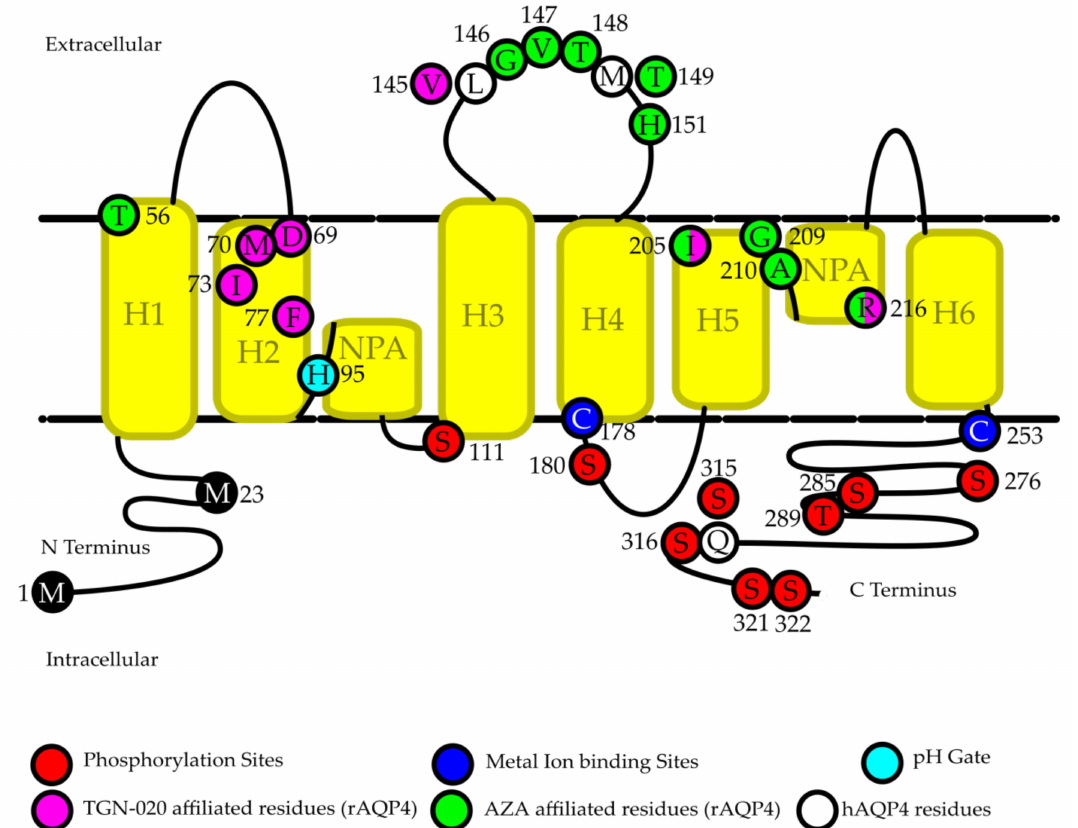
Figure 1. Important residues in AQP4 regulation. The location and function of several important residues identified to have a role in AQP4 regulation. White residues indicate the human equivalent to sites which were identified in rat AQP4 (rAQP4) as having important regulatory functions but are